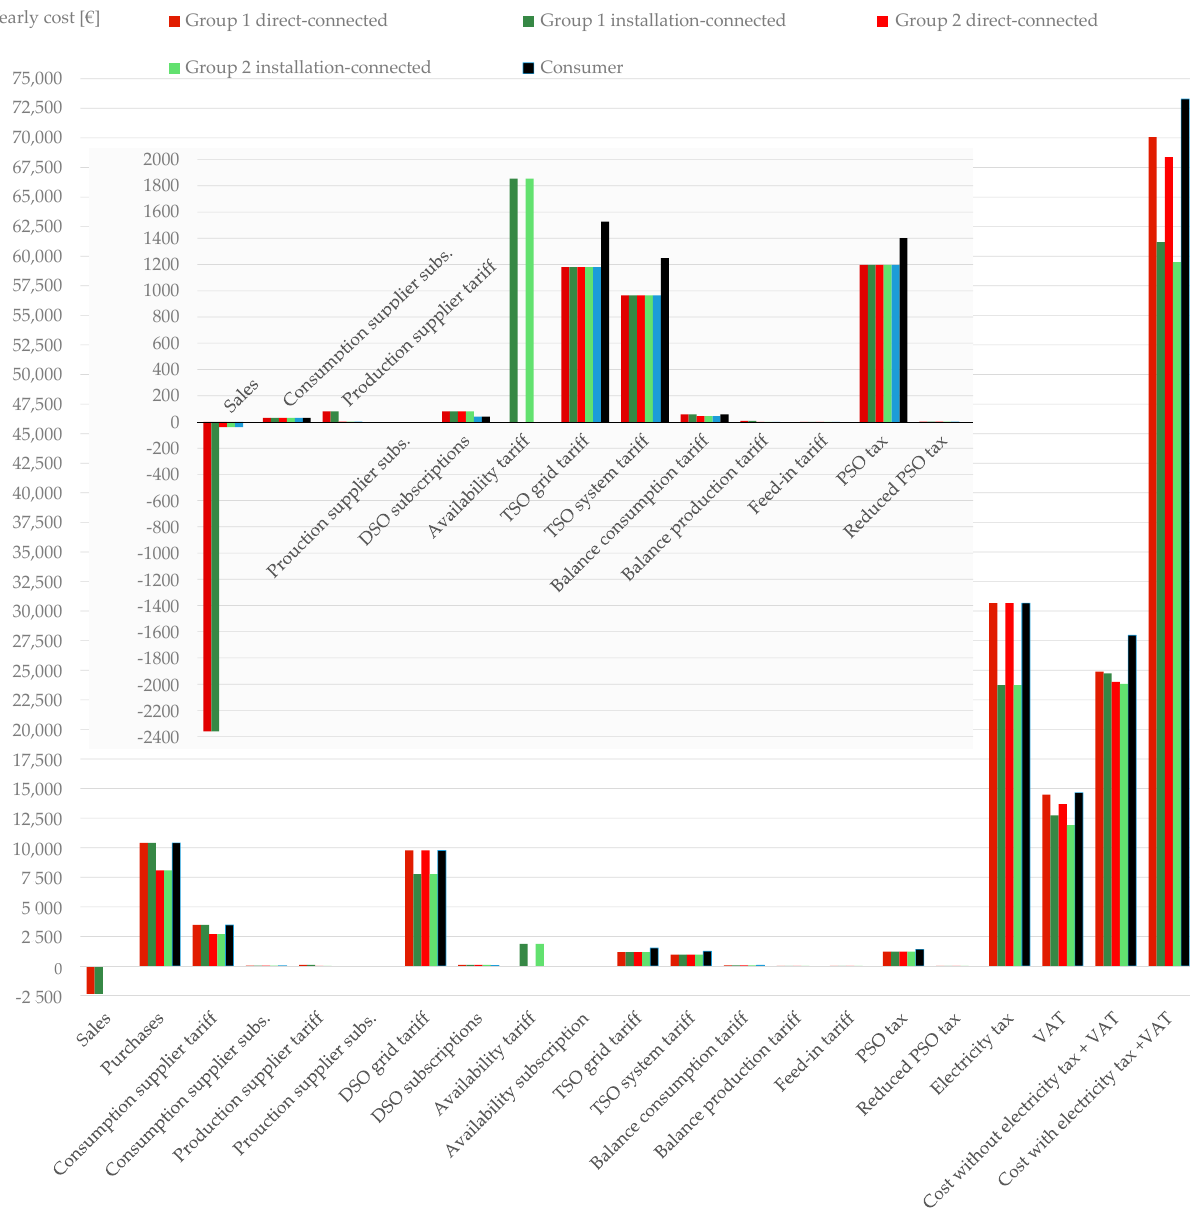
Figure 5. Yearly cost of electricity with decomposition into the several billing concepts. Self-elaboration.